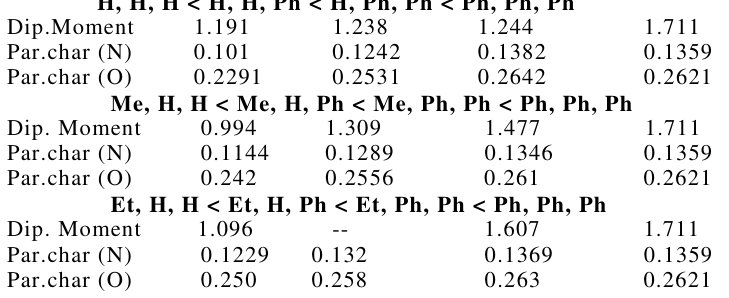
Table records the magnitudes of physico-chemical constants viz ., dipole moments, van der Waal forces and the molar volumes. The partial charges (in esu) values for oxygen and nitrogen atoms have also been recorded in their adjacent columns. A perusal of the values, in general, shows a marked dependence of the physico- chemical parameters on their respective substitutions. Dipole moment value, which is indirectly, related to the molecular des-symmetry of charges show a marked increase with bulkier substituents. These physico-chemical parameters showed dependence with respect to their X , X and X substituents as: 1 2 3